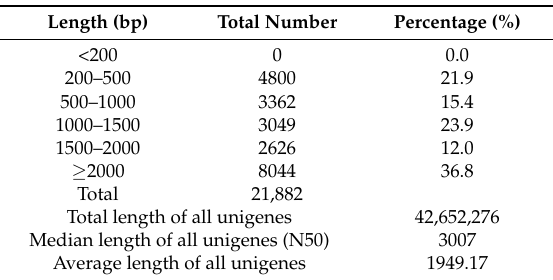
Table 1. Overview of transcriptome sequencing and assembly for P.